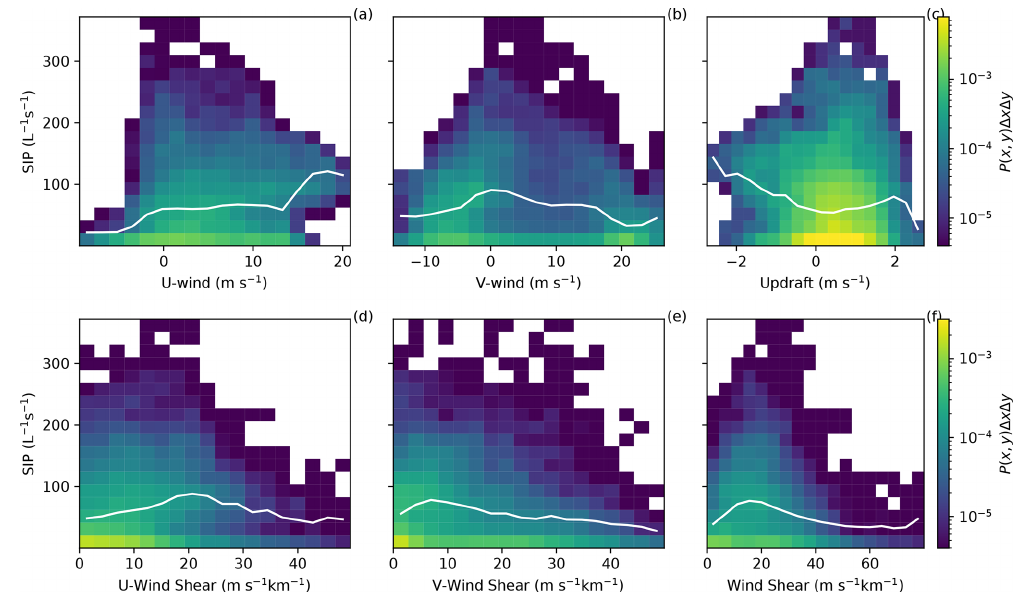
Figure 10. Joint probability density function multiplied by bin area ( P ( x,y ) (cid:49)x(cid:49)y ) for the model output of SIP versus (a) U wind, (b) V wind, (c) updraft, (d) U-wind shear, (e) V-wind shear and (f) wind shear for the BR2.8T simulation. White lines are the 50th per- centile as a function of the x -axis variable. Table 2. The 25th, 50th and 75th percentiles and the interquartile range (IQR) between the 10th and 90th percentiles of the vertical profiles for the BR2.8T simulations. Time (UTC) Variable 25th perc. 50th perc. 75th perc.